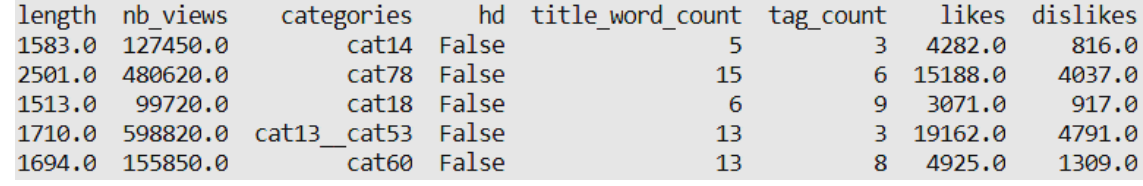
Figure 2. Sample of the Dataset